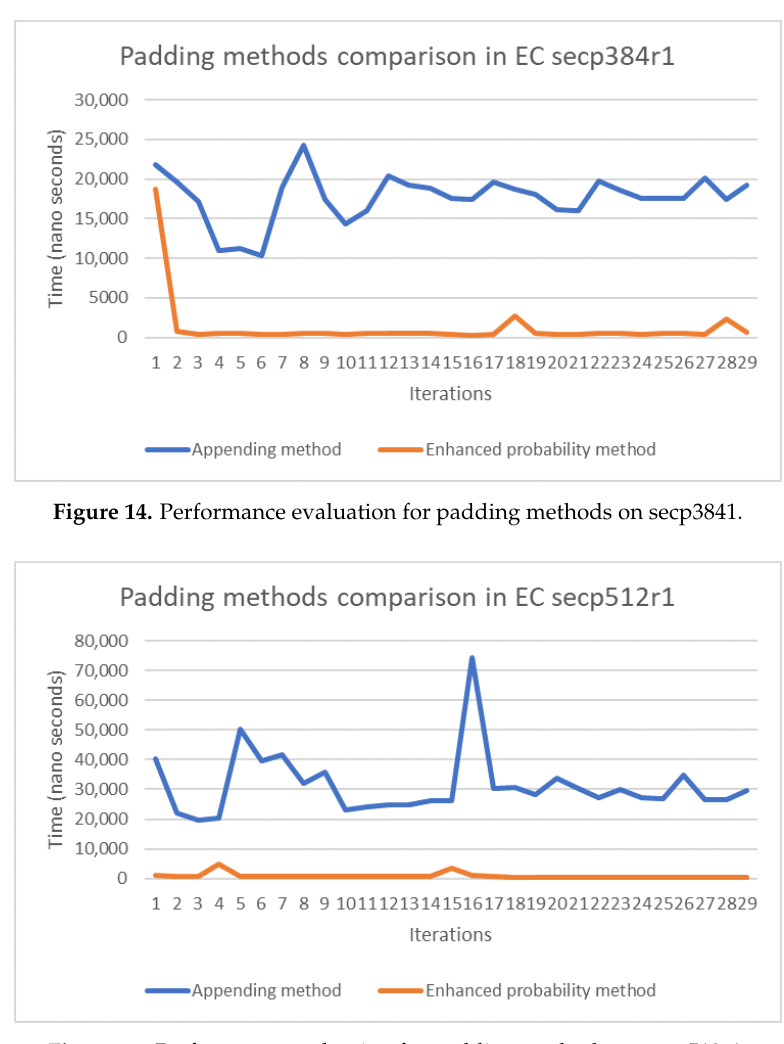
Figure 15. Performance evaluation for padding methods on